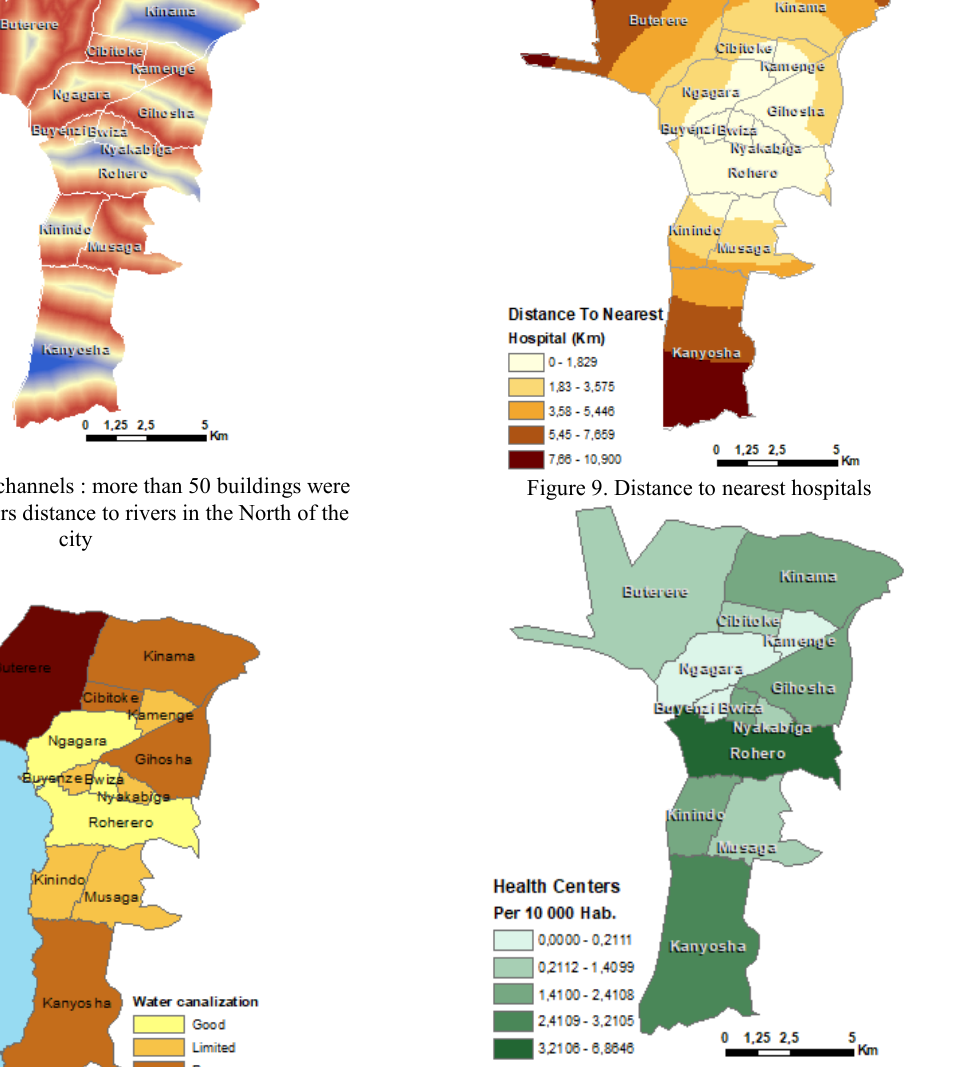
Figure 10. Number of Health Centers by municipality